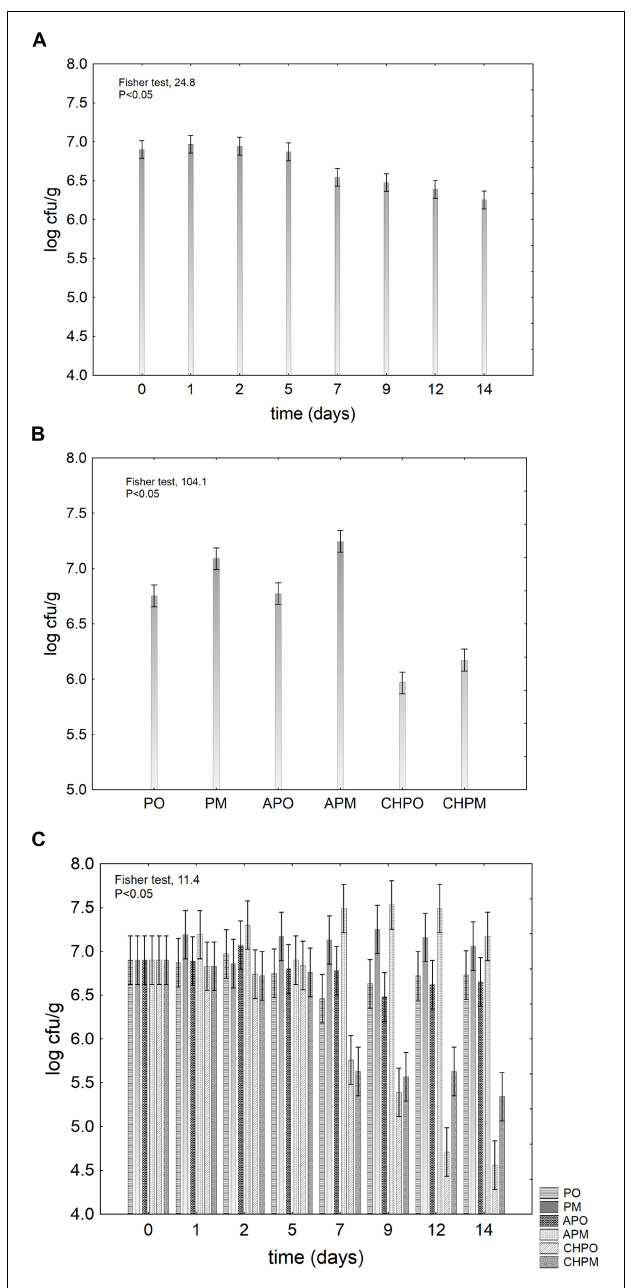
FIGURE 1 | Decomposition of the statistical hypothesis for the effect of the kind of treatment and the storage time on the viability of Lactobacillus plantarum c19 on apple pieces. Vertical bars denote 95% confidence intervals. (A) effect of the storage time; (B) effect of the treatment; (C) interaction time/treatment. For the acronyms of samples see Materials and Methods.